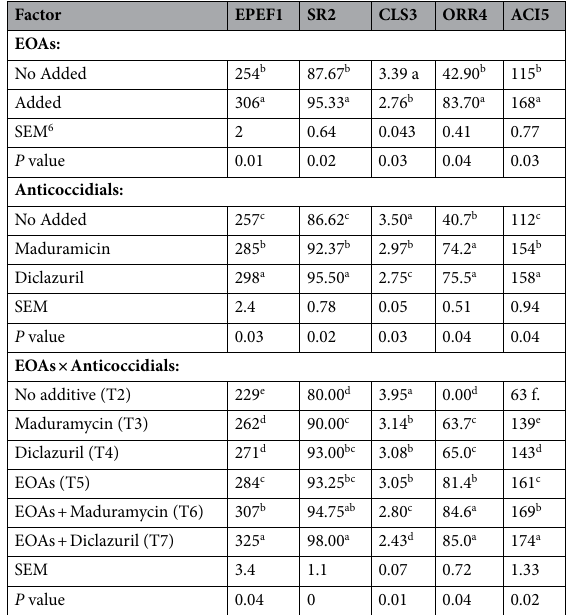
Table 2. Effect of EOAs and anticoccidials on EPEF 1 , SR 2 , CLS 3 , ORR 4 and ACI 5 in infected broilers. a–b In each column, means with no same (a, b) superscript differ significantly in p < 0.05 value. 1 European production efficiency factor; 2 Survival rate; 3 Caecal lesion score, 4 Oocyst reduction rate; and 5